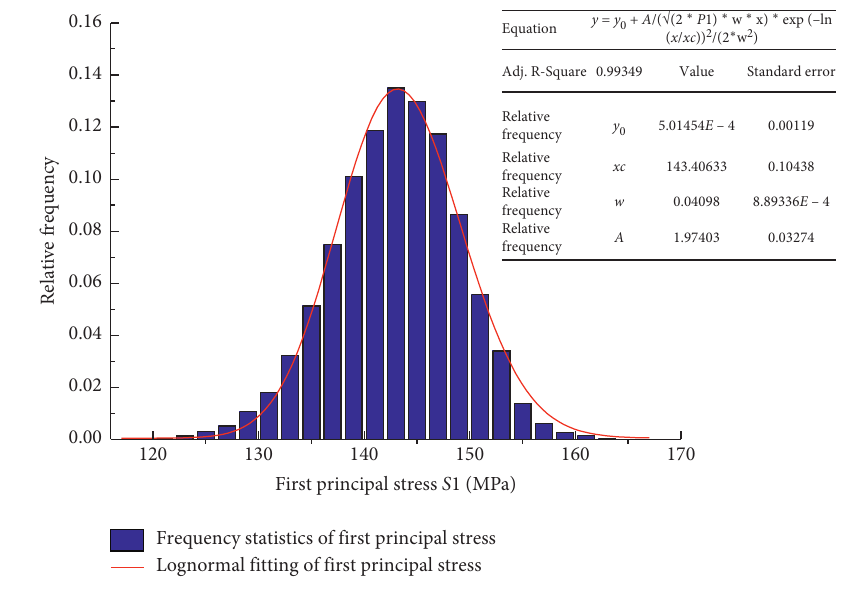
Figure 7: Lognormal distribution fitting of